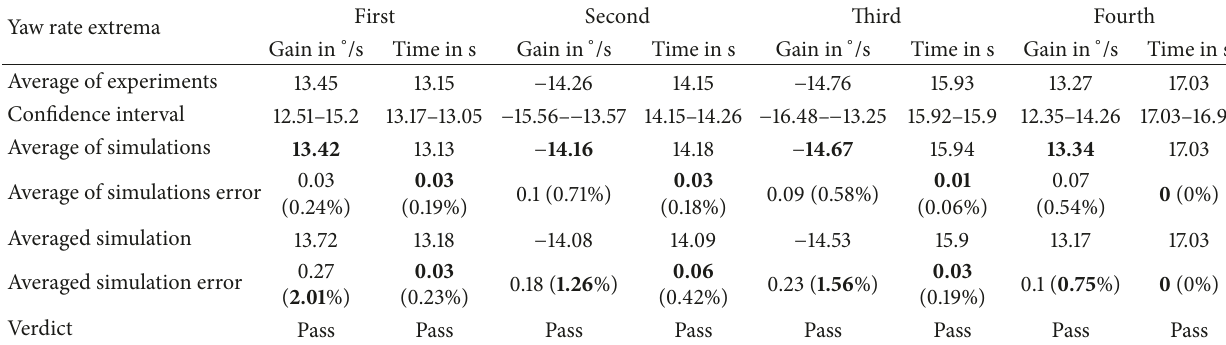
Table 8: Validation results Maneuver Lat-II: yaw rate